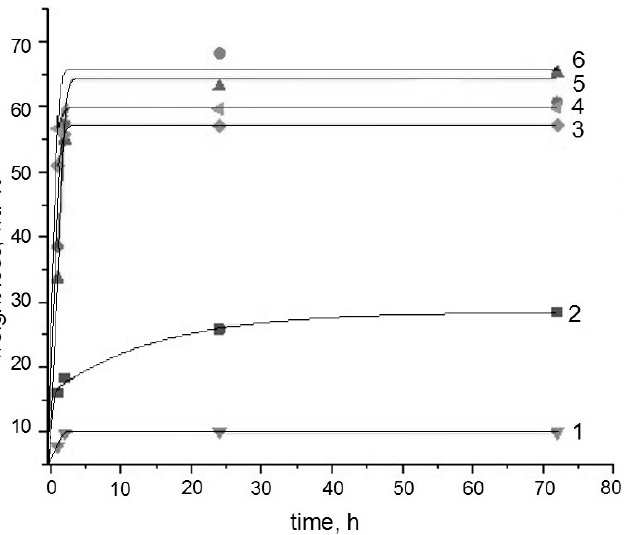
Figure 2. Weight loss kinetics for the binary composite films in the HCl solutions at 40 ° С . The numbers show: Solution concentrations are 0.005 (1), 0.1 (3), 0.2 (5) mol/L for a PHB-chitosan system and 0.005 (2), 0.1 (4), 0.2 (6) mol/L for a PLA-chitosan system.